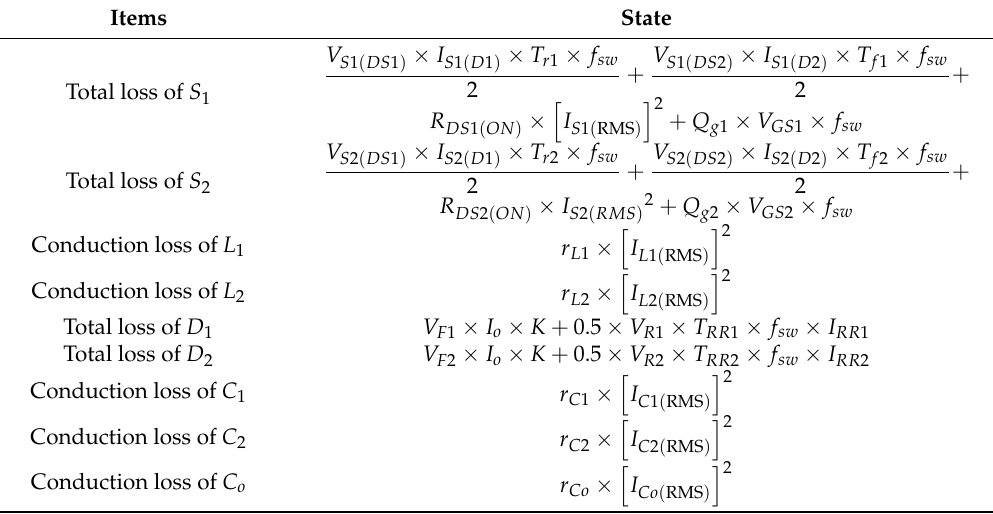
Table 2. The equations of loss in steady-state.